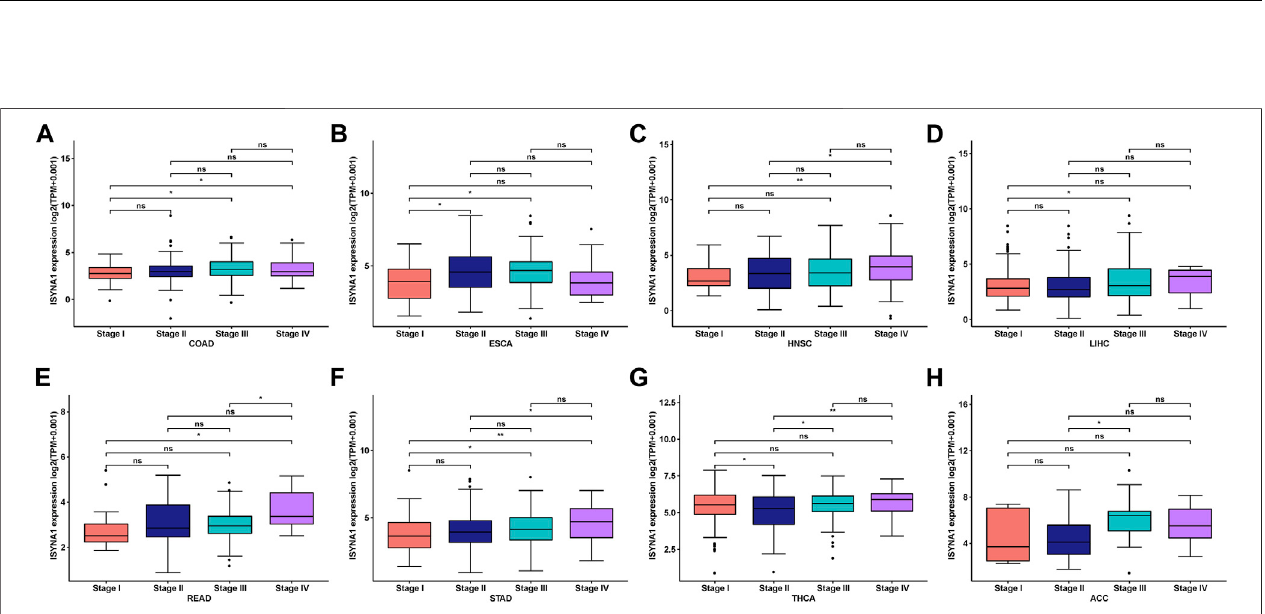
FIGURE 3 | (A – H) ISYNA1 expression in various tumor stages in indicated tumor types. * p < 0.05, ** p < 0.01, *** p < 0.001, **** p < 0.0001.